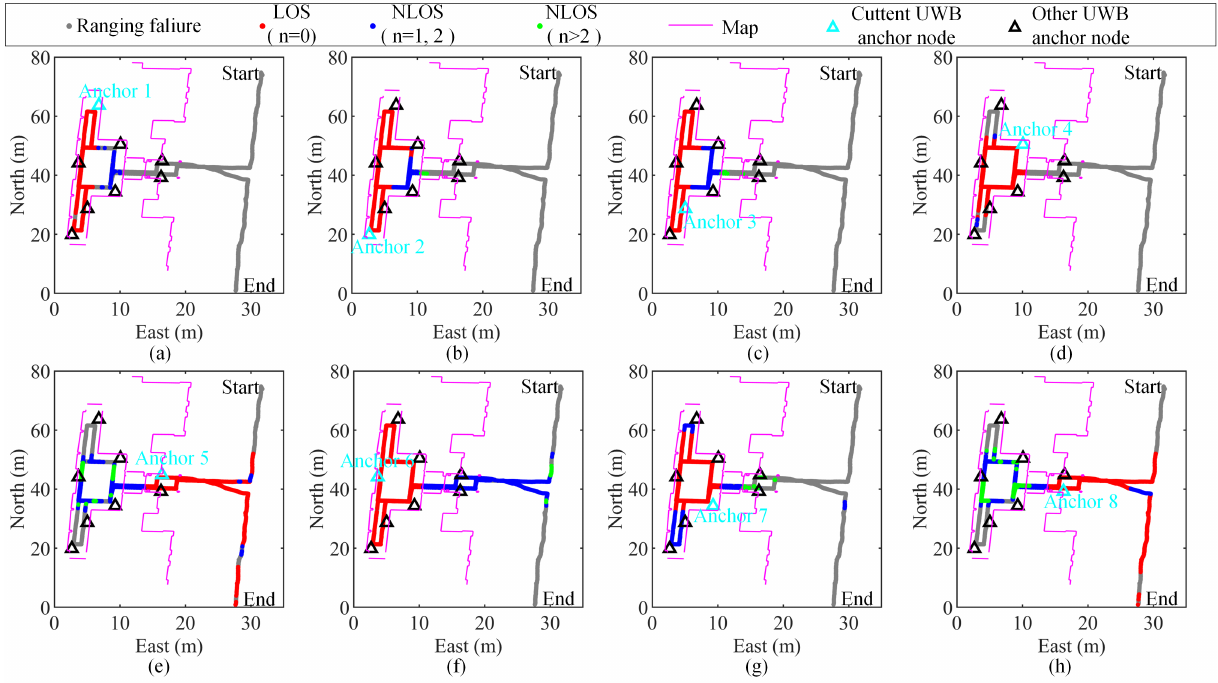
Figure 8. Occlusion status on the map for different UWB anchor nodes: ( a ) anchor node 1; ( b ) anchor node 2; ( c ) anchor node 3; ( d ) anchor node 4; ( e ) anchor node 5; ( f ) anchor node 6; ( g ) anchor node 7; ( h ) anchor node 8. The light blue and black triangles indicate the positions of the current UWB anchor node and other UWB anchor nodes, respectively. The dots of different colors represent various occlusion states of the current UWB anchor node (including ranging failure, LOS conditions, and NLOS